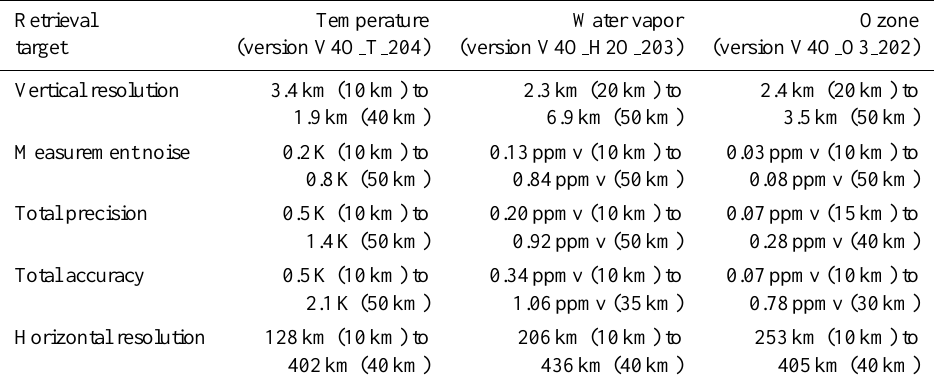
Table 1. Data and error chararacterization of temperature, water vapor, and ozone retrieved from MIPAS level-1b version 4.67 spectra (optimized-resolution nominal observation mode) at